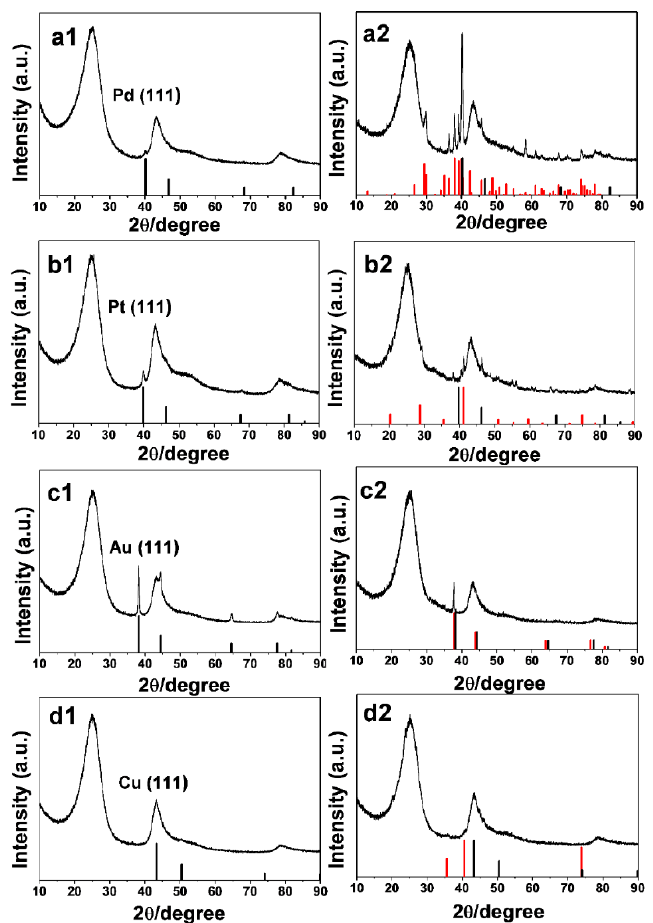
Figure 2. XRD result of the electrodeposited metals and corresponding amalgams, ( a1 ) Pd, ( a2 ) PdHg800, ( b1 ) Pt, ( b2 ) PtHg800, ( c1 ) Au, ( c2 ) AuHg800, ( d1 ) Cu and ( d2 ) CuHg800: (black) metal, (red) Hg alloy .